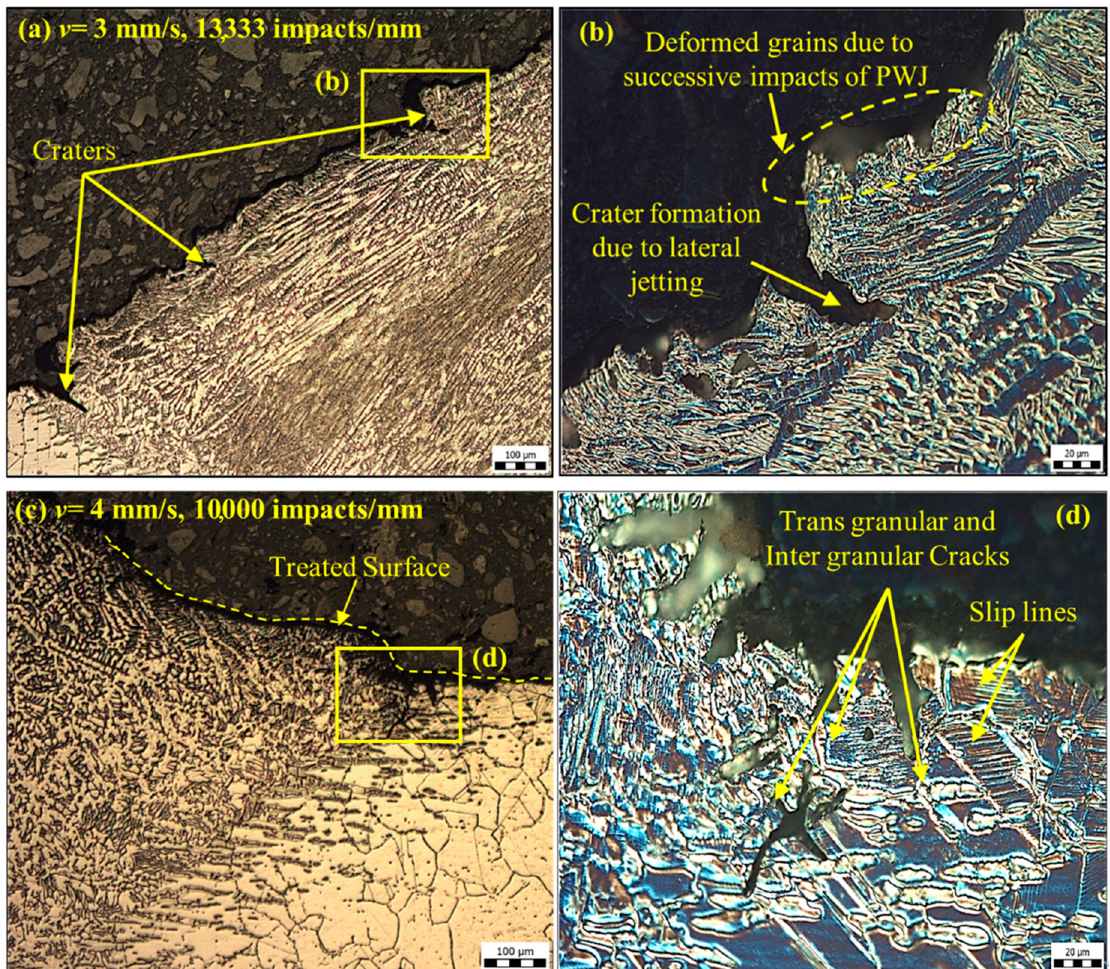
Figure 6. Optical microscopy of a cross-section of the samples treated by pulsating water jet (PWJ) at f = 40 kHz ( a ) at v = 3 mm/s (100 µ m), with ( b ) a magnified view at 20 µ m, and ( c ) at v = 4 mm/s (100 µ m), with a ( d ) magnified view at 20 µ